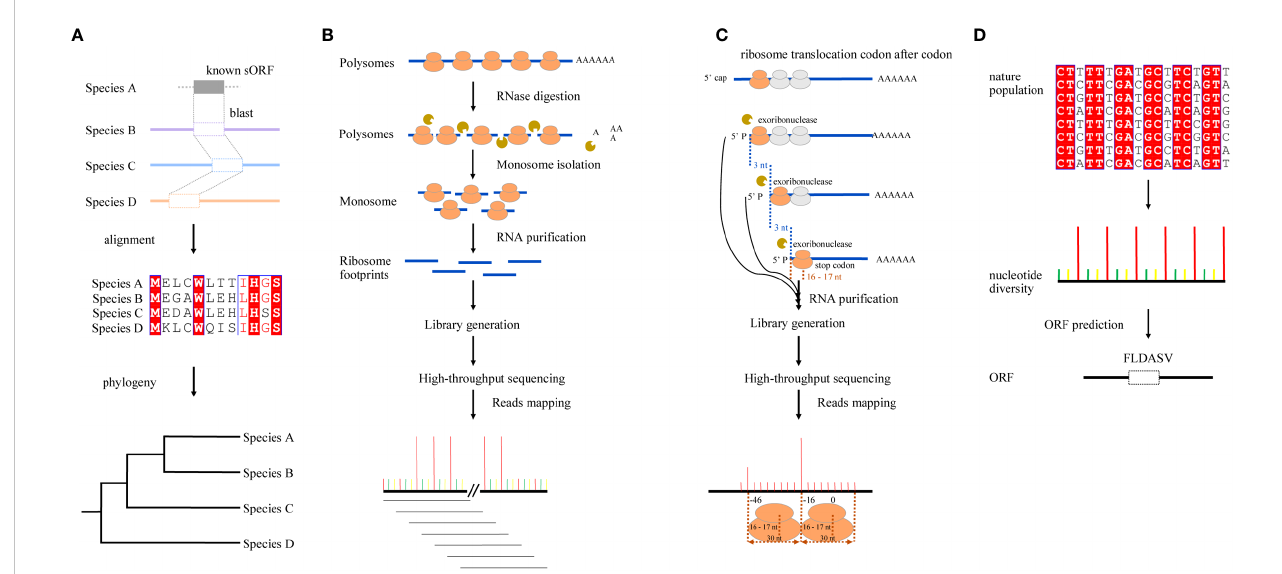
FIGURE 1 Graphic illustration for four different strategies of sORF identi fi cation. (A) Sequence conservation-based. It is assumed that functional sORFs are preserved by natural selection and are conserved across species; sORF identi fi cation could be based on sequence similarities using sequence alignment tools, such as BLAST. (B) RFP-based. The ribosome-associated mRNAs are digested by RNase and the fragments bound by ribosome are protected; they can then be isolated and sequenced using next-generation sequencing (NGS) technology. As ribosomes move along mRNA strands with a step of three nucleotides during the translation of mRNAs, the mapping loci of RPFs on mRNAs show a strong 3-nt periodicity. (C) Degradome sequencing-based. 5 ’ - 3 ’ exoribonuclease digests translating mRNAs chasing after the last translating ribosome, which translocates codon after codon on mRNAs, leaving truncated 5 ’ monophosphate mRNAs with a 3-nucleotide distance in length. After sequencing, this 3-nucleotide periodicity in the position of free 5 ’ mRNA ends can then be used for sORFs identi fi cation. (D) Natural nucleotide diversity-based. As only the nucleotide diversities in CDSs showed a signi fi cant 3-nt periodicity, the single-nucleotide polymorphism (SNP) datasets of natural populations can be used to predict